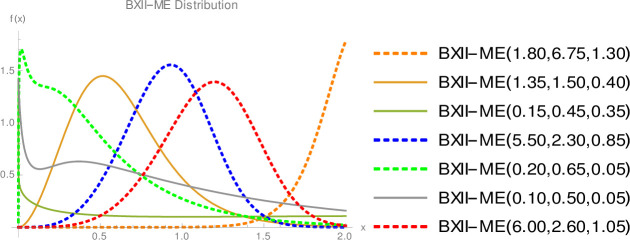
Plots of the BXII-ME density.